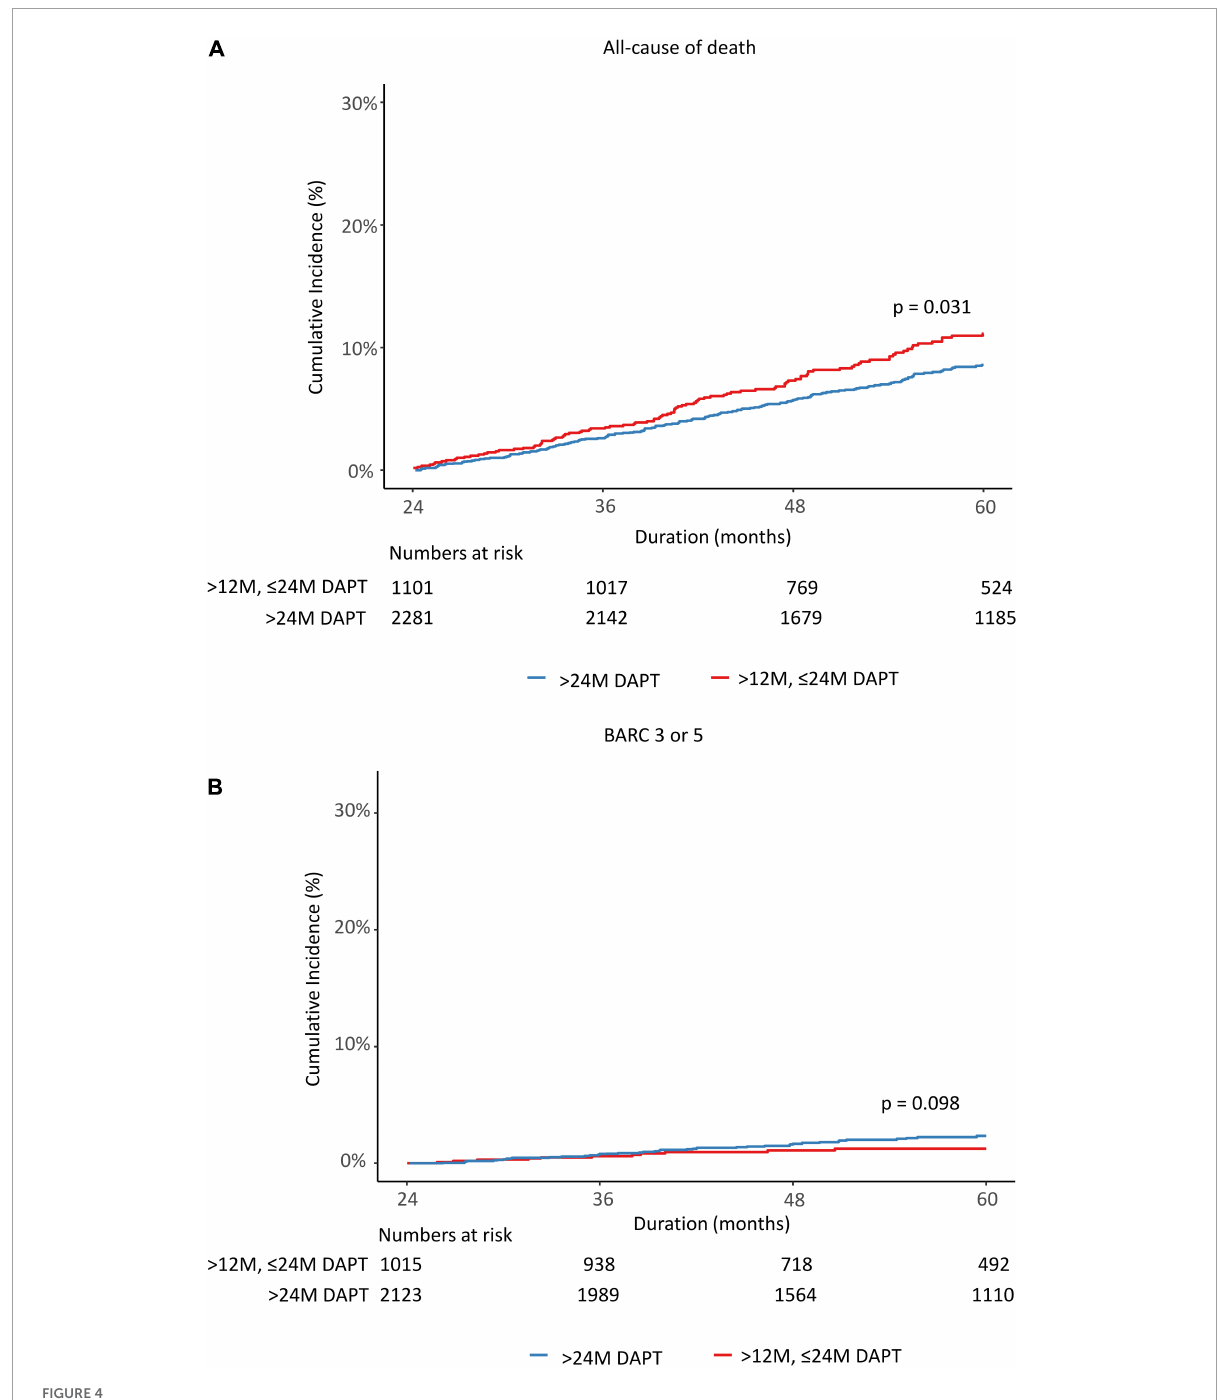
baseline, clinical, laboratory, and medication data. Any